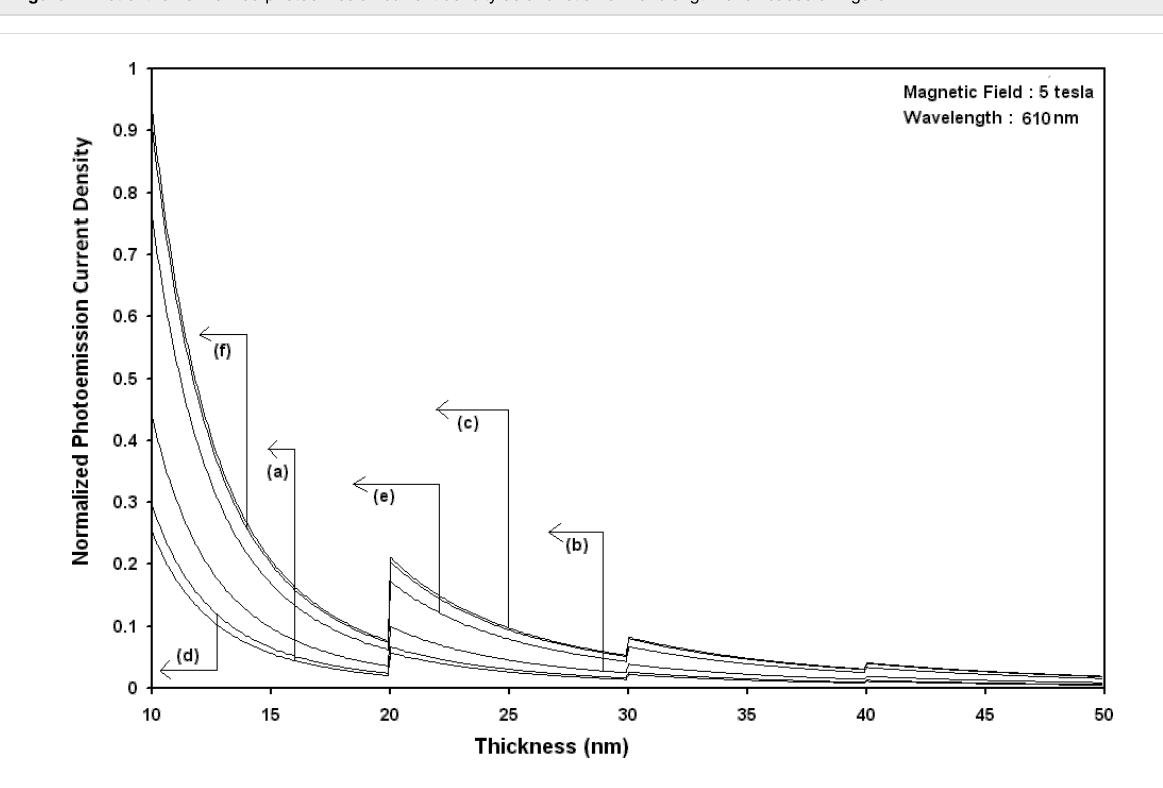
Figure 4: Plot of the normalized photoemission current density as a function of wavelength for all cases of Figure 1.